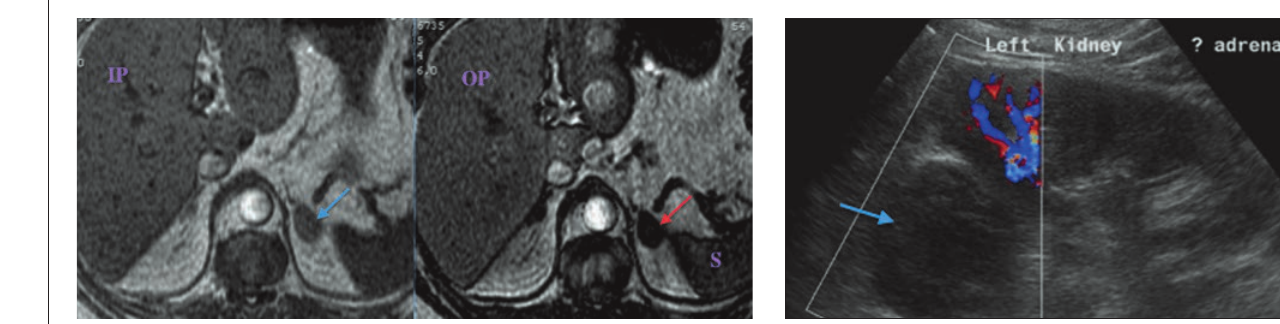
Fig. 3. Longitudinal ultrasound image demonstrating a well- defined, solid hypo-echoeic left suprarenal mass (blue arrow), which was a pathologically confirmed adenoma.